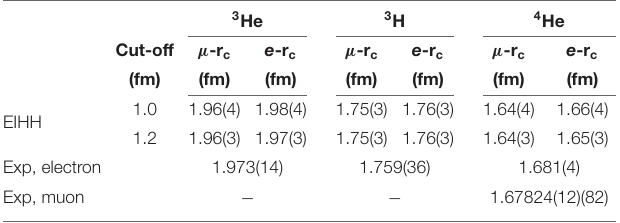
TABLE 4 | Nuclear rms charge radii for 3 He, 3 H, and 4 He systems at N2LO computed using either the single-nucleon CODATA-2014 values (columns e -r c ) or the more precise muonic atoms data (columns µ -r c ).